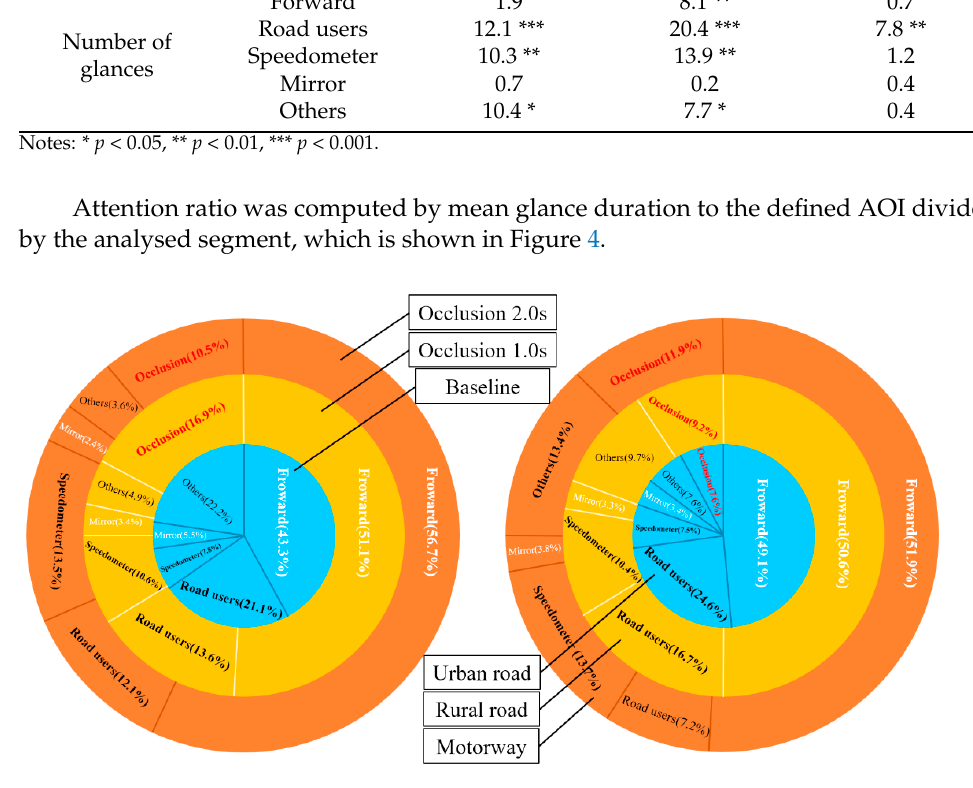
Figure 4. Attention ratio distribution as a function of occlusion duration ( left ) and driving scenario ( right ). ( right